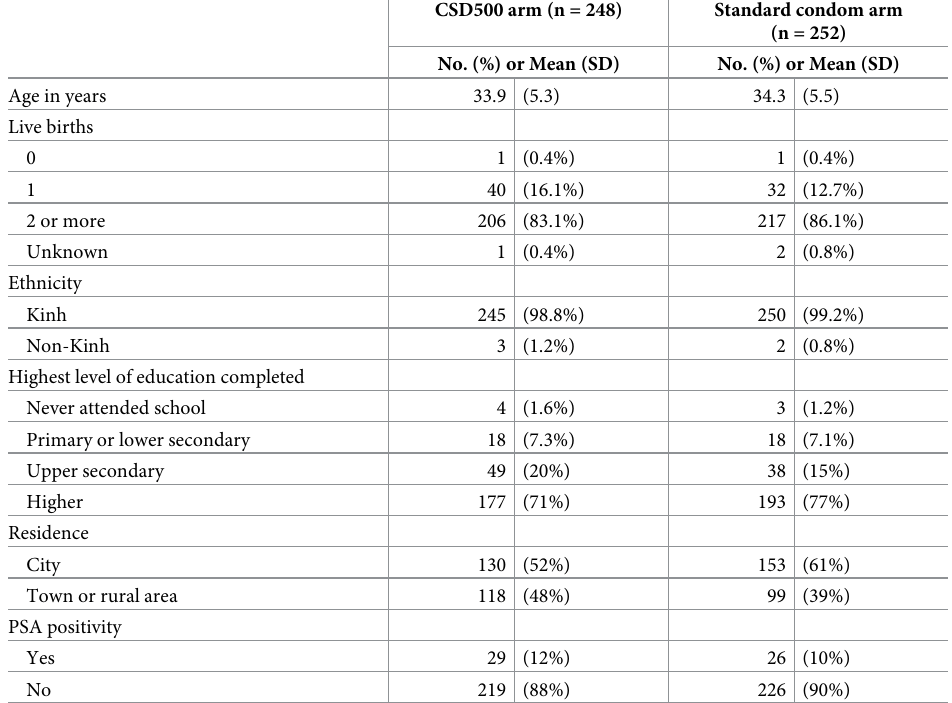
Table 2. Characteristics of female participants at enrollment by study arm for intent-to-treat population (N =